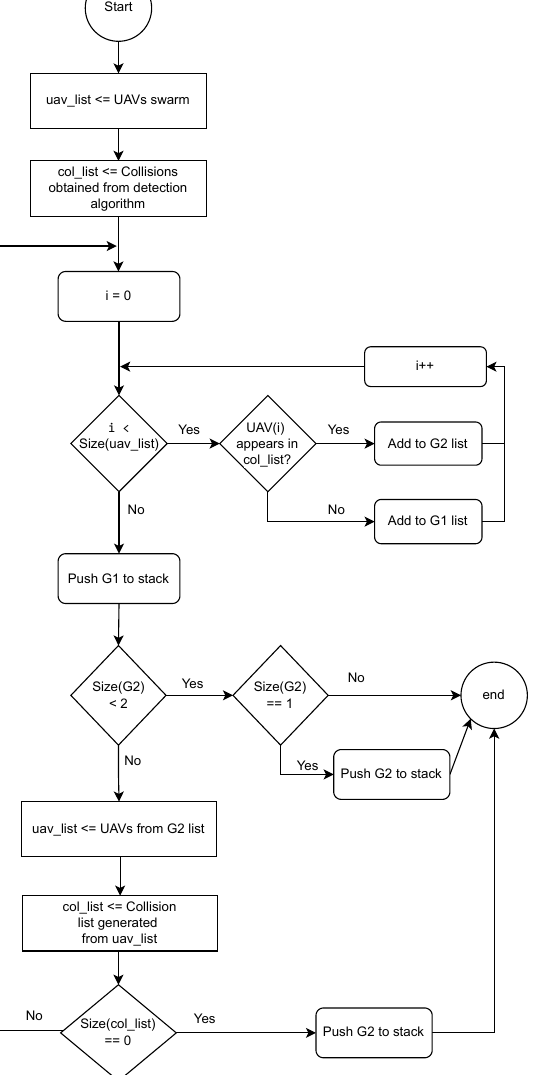
Figure 10. Flowchart representing the batch generation